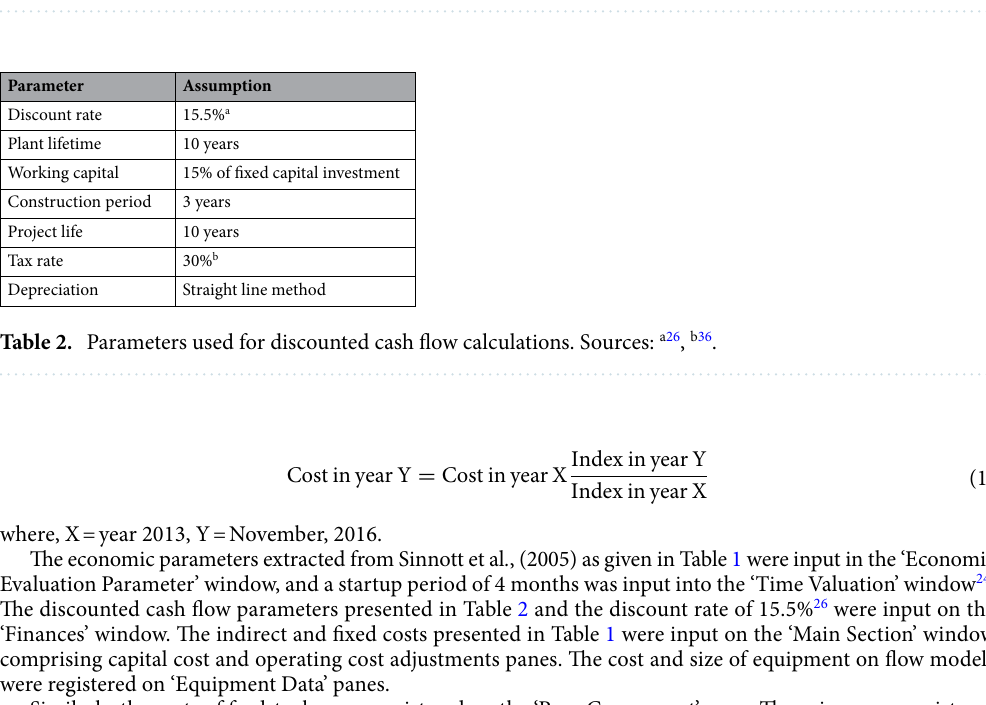
Table 1. Assumed parameters’ values. Source: 36 . TIE total installed equipment.